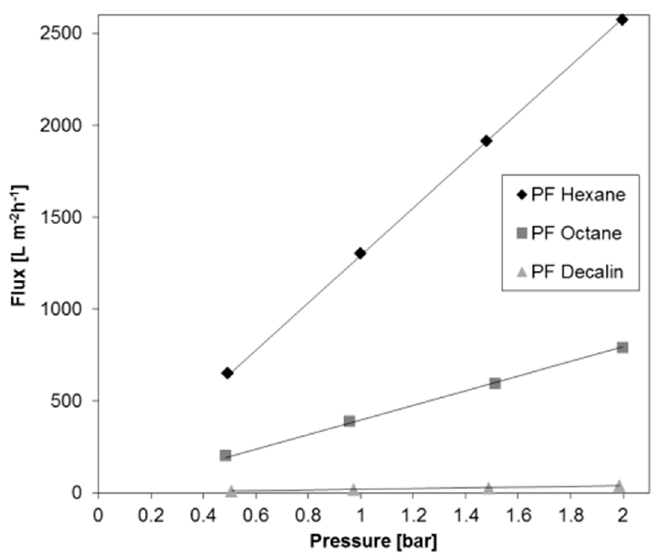
Figure 3. Flux through the BCPM of three perfluorinated (PF) compounds of various viscosity plotted against the trans-membrane pressure.